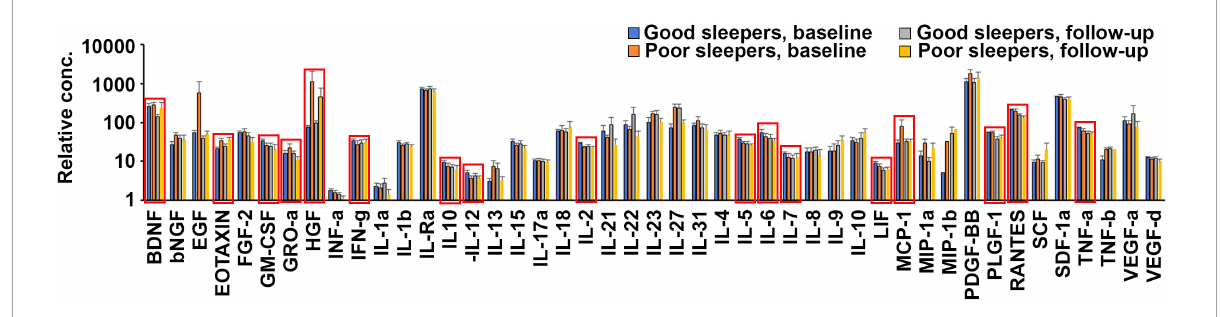
FIGURE2 Poor and/or deteriorated sleep quality during oncological treatment is coupled to changes in plasma levels of 17 cytokines. Quantification of the average levels of 45 cytokines in the plasma of patients reporting good (aggregated MOS score < 24, n = 9) and poor (aggregated MOS score > 25, n = 8) sleep at baseline or follow-up, after 3 months of oncological treatment. Significant ( p < 0.1) differences were observed between good and poor sleepers at baseline for Eotaxin, IFN-g, IL12, IL2, IL5, and MCP-1, between good and poor sleepers at follow-up for GRO-a and IL6 and for those exhibiting good sleep at baseline that deteriorated to poor sleep at follow-up for BDNF, GM-CSF, HGF, IL10, IL5, IL7, LIF, PlGF, RANTES, and TNF-a. These 17 biomarkers are indicated with red boxes in the